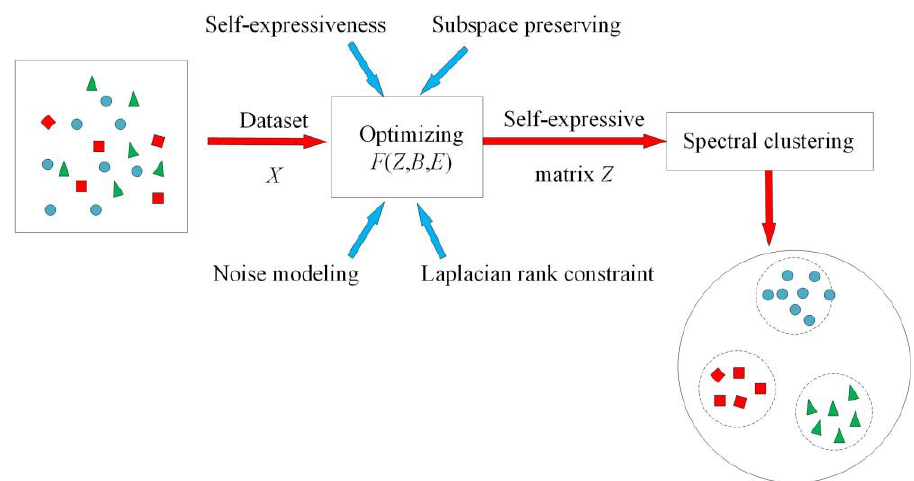
Figure 1. The framework of OBDR.